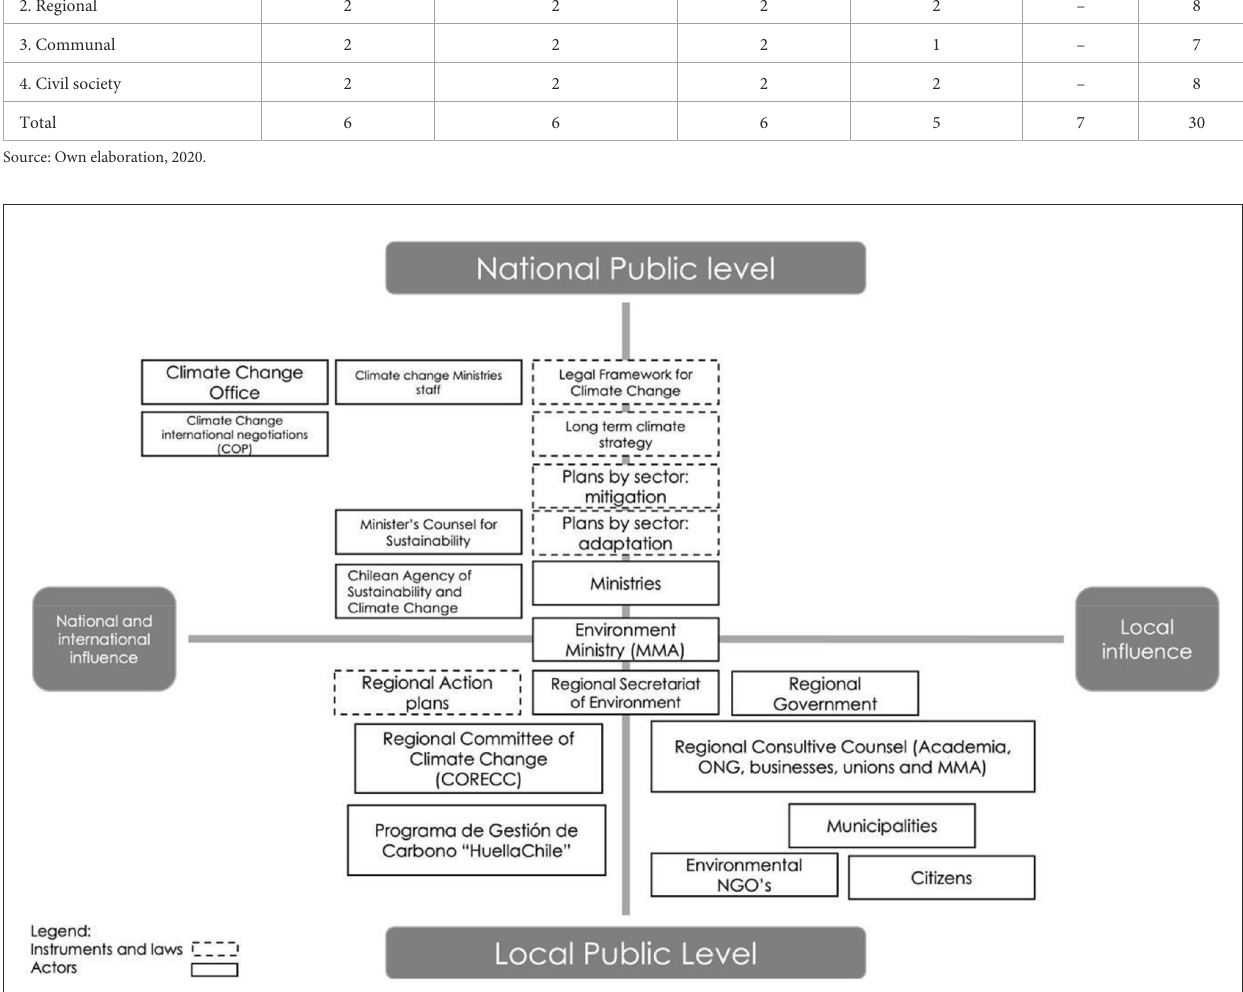
dimensions and thematic axes. The codes were grouped into categories providing content analysis for each of the scales (national, regional, communal, and civil